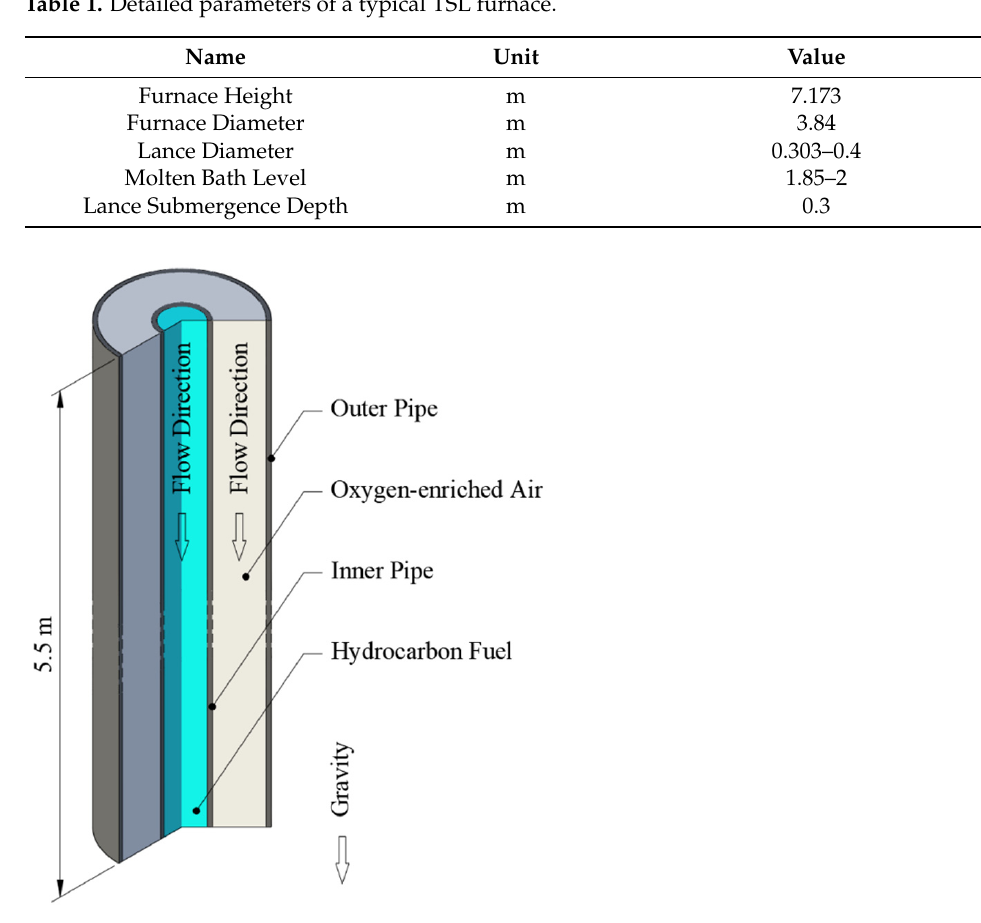
Figure 1. Schematic diagram of the TSL